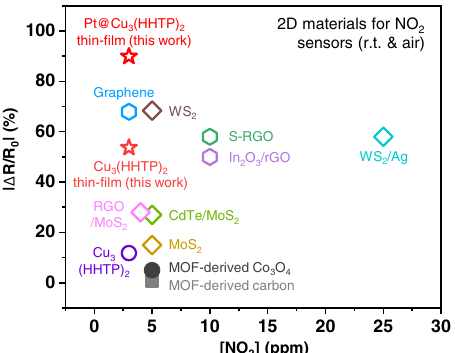
Fig. 5 Comparison of the NO 2 responses of Pt@Cu 3 (HHTP) 2 thin- fi lm and Cu 3 (HHTP) 2 thin- fi lm with those of other materials. Other materials include Cu 3 (HHTP) 2 , graphene, WS 2 , RGO/MoS 2 (RGO: reduced graphene oxide), CdTe/MoS 2 , MoS 2 , MOF-derived CO 3 O 4 , MOF-derived carbon, S- RGO (S-RGO: sulfonated RGO), In 2 O 3 /RGO, and WS 2 /Ag. / means heterostructured